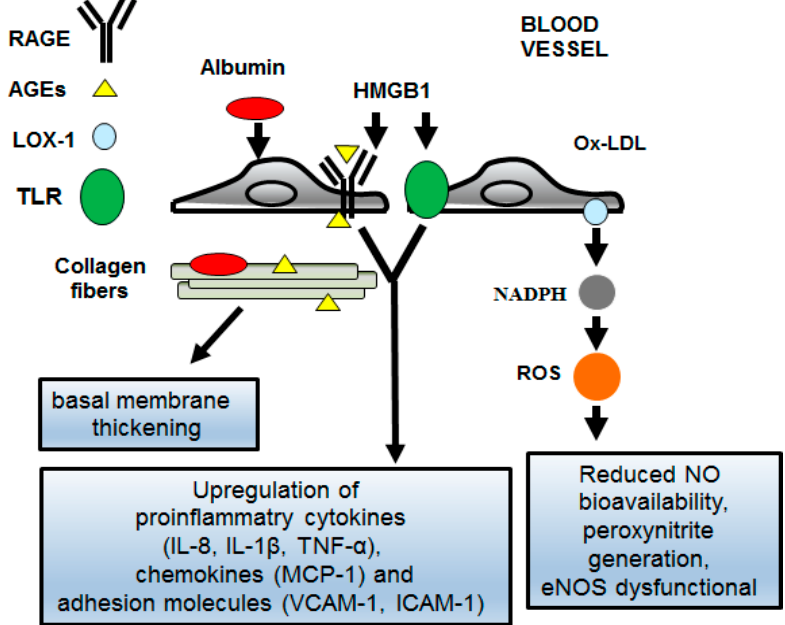
Figure 1. Molecular pathways associated with diabetic macroangiopathy. The figure depicts some of the key points discussed in the text on the role of advanced end products (AGE) products, innate immunity, and reactive oxygen species generation in diabetic macroangiopathy. Abbreviations: RAGE, receptor for advanced glycation end products; AGEs, advanced glycation endproducts; TLR, Toll-Like Receptor; HMGB1, high mobility group box 1; IL, interleukin; TNF- α , tumor necrosis factor alpha; MCP-1, Monocyte chemoattractant protein-1; VCAM-1 vascular cell adhesion molecule 1; ICAM-1, intercellular adhesion molecule 1; ROS, reactive oxygen species; ox-LDL, oxidized low-density lipoprotein; NADPH, nicotinamide adenine dinucleotide phosphate; NO, nitric oxyde; eNOS, endothelial nitric oxide synthase.